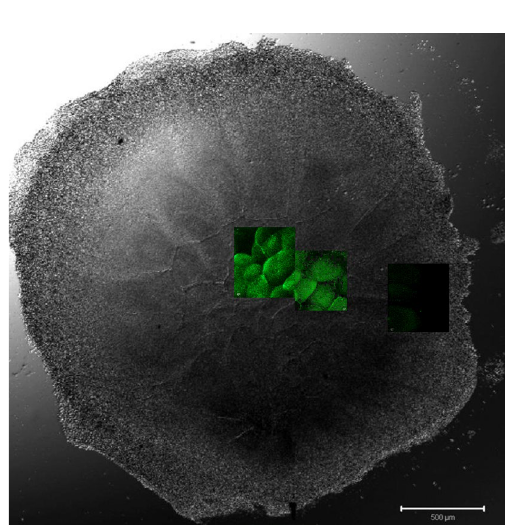
Figure 7. Overview of an intrauterine embryo (EGK III) with two frames of the central region with Bucky ball immunolabeling in contrast to severely reduced immuno-fluorescence at the lateral outline of furrows. The two frames in the central region show the cells with Bucky ball immunofluorescence in cytoplasmic granular distribution. The lateral frame, documented at the exactly comparable acquisition conditions, does not provide signals above background. Scale = 500